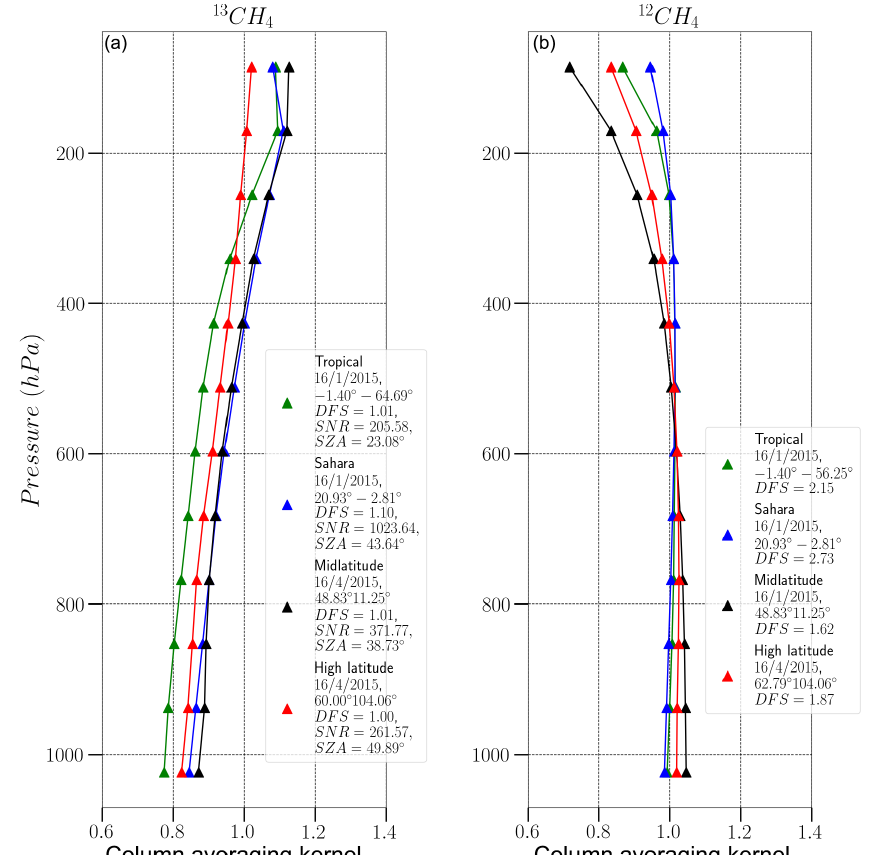
Figure 8. As Fig. 2 but focused on the Sentinel-5/5P SWIR3 band.